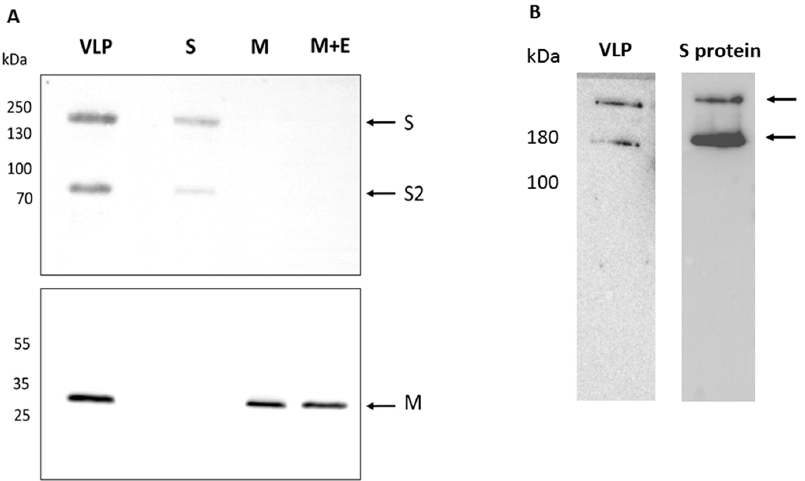
Figure 2. Expression of SARS-CoV-2 structural proteins by recombinant baculoviruses. ( A ) Individual recombinant virus infections of Sf9 cells were harvested at 2 days post infection and total cell extracts analyzed by SDS-PAGE and Western blot with appropriate antibodies. The lanes are: VLP—virus expressing structural proteins S, M and E; S—virus expressing S only; M—virus expressing M only; M + E—virus expressing M and E. The upper panel was probed with an anti-S antibody and the lower panel probed with an anti-M antibody. ( B ) Western blot of cell extracts from virus infected cells expressing S only or S as part of the VLP construct after electrophoresis under conditions of low denaturation. The position of bands with molecular masses consistent with monomer and trimer are indicated. Markers to the left of the gels are in